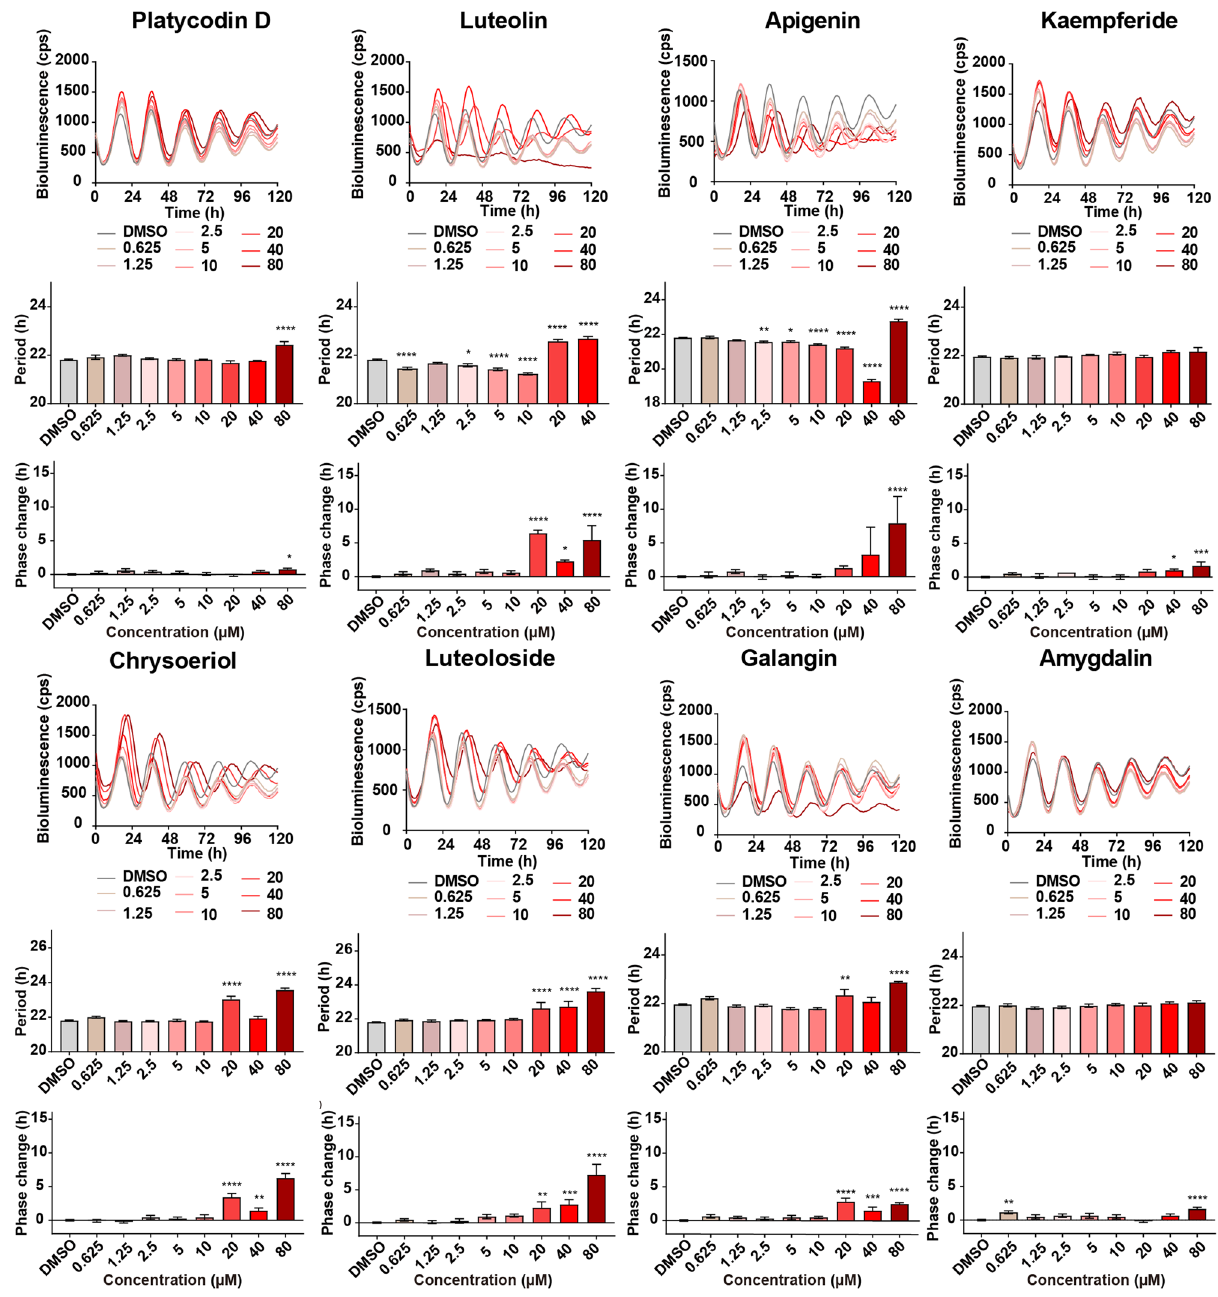
Figure 5. Effects of 8 major ingredients of hit crude drugs. Luminescent traces (top) and dose-dependent effects on the circadian period (middle) and phase (bottom) in U2OS cells. Values are the mean of six replicates ± SD and were analyzed using one way ANOVA, followed by Dunnett’s multiple comparisons test (* p < 0.05, ** p < 0.01, *** p < 0.001, **** p <